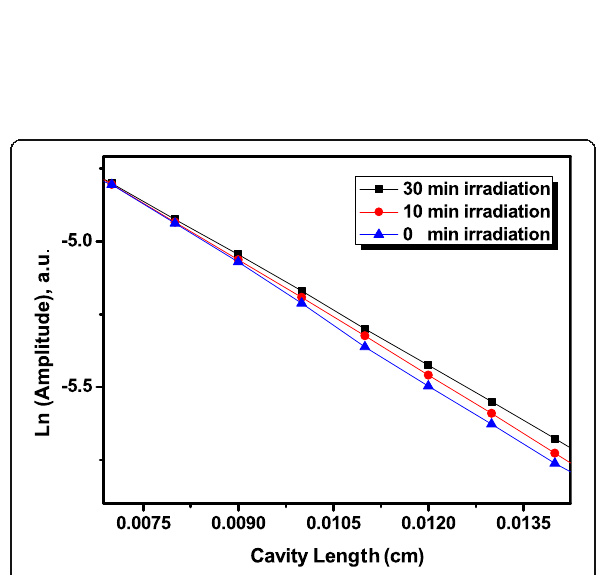
Fig. 7 Typical logarithmic amplitude as a function of the relative cavity length of Al 2 O 3 nanofluids at different irradiation time [0, 10, and 30 min]